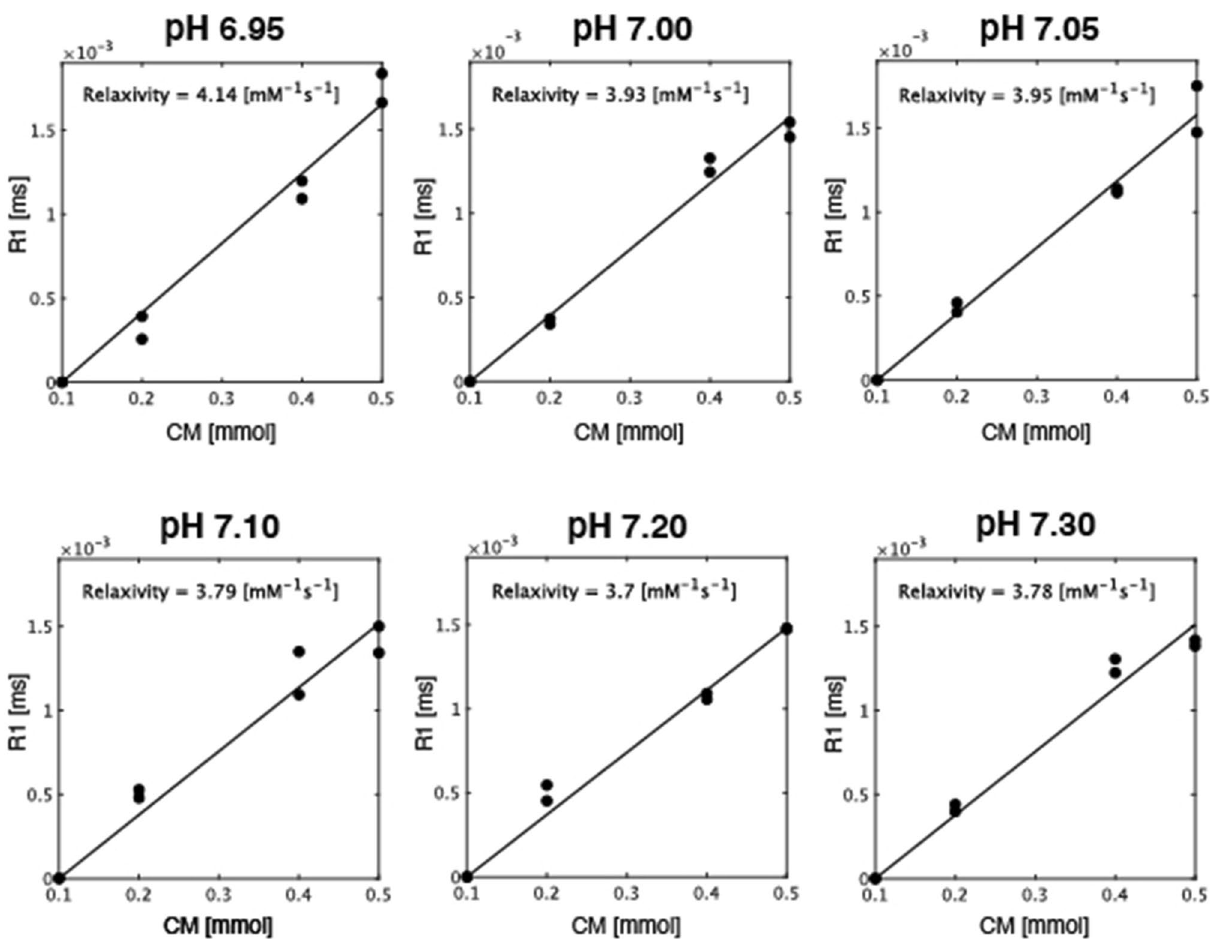
Figure 2. Determination of Gd-BTDO3A relaxivity at 3.0 T MRI. Relaxation rates (1/T1) were plotted against the concentration of four Gd-BTDO3A concentrations (0.1, 0.2, 0.4 and 0.5 mmol) at body temperature (37 °C), respectively. The relaxivity value was then determined from the slope of the linear regression of each pH